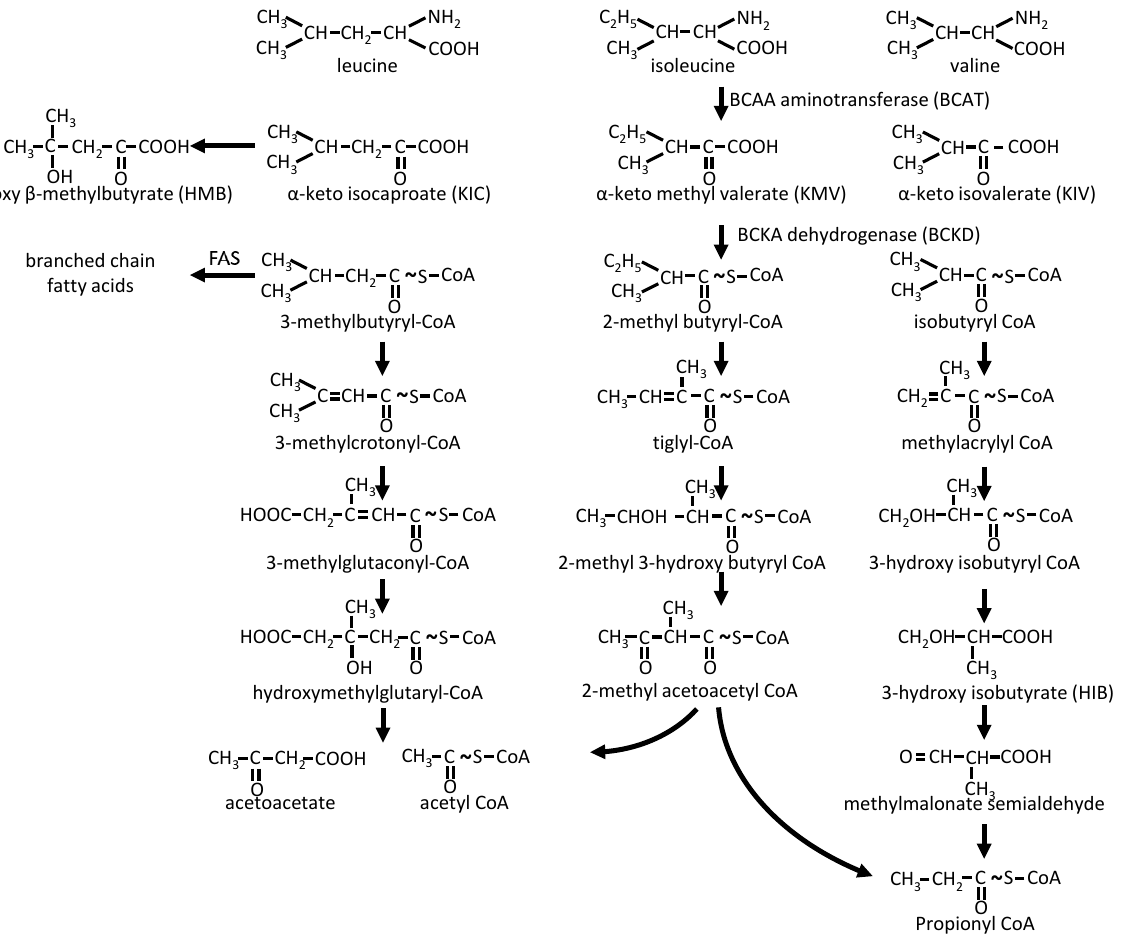
Figure 2. BCAA catabolic pathways. FAS: Fatty acid synthase. Following their metabolization by BCKD, branched-chain acyl-CoA are mainly de- graded by their cognate enzymes into aceto-acetate and acetyl-CoA (leucine), propionyl- CoA, and acetyl-CoA (isoleucine) or propionyl-CoA (valine). Note that the penultimate step of leucine degradation is the degradation of 3-hydroxy-3-methylglutaryl-CoA by its lyase, the last enzyme of ketone body formation in the liver. In addition, propionyl-CoA is further metabolized into methylmalonyl-CoA and then into succinyl-CoA, feeding into the tricarboxylic acid (TCA) cycle. Last, some of the intermediates of this metabolism can serve as precursors of branched-chain and odd-chain fatty acids [19] or can escape the mitochondria as acyl-carnitines (C5 and C3 acylcarnitines), as hydroxyisobutyrate (HIB, valine catabolism), or as beta-amino-isobutyric acid (BAIBA, a product of the valine derivative methylmalonic semialdehyde)